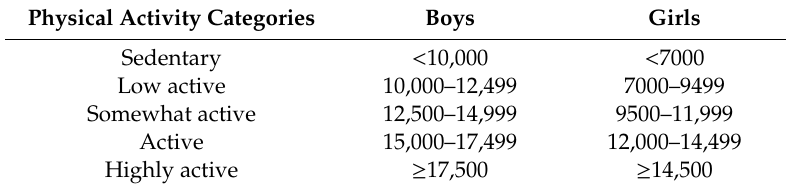
Table 1. Physical activity categories and sex-specific intervals for children (ages 6–12 years)